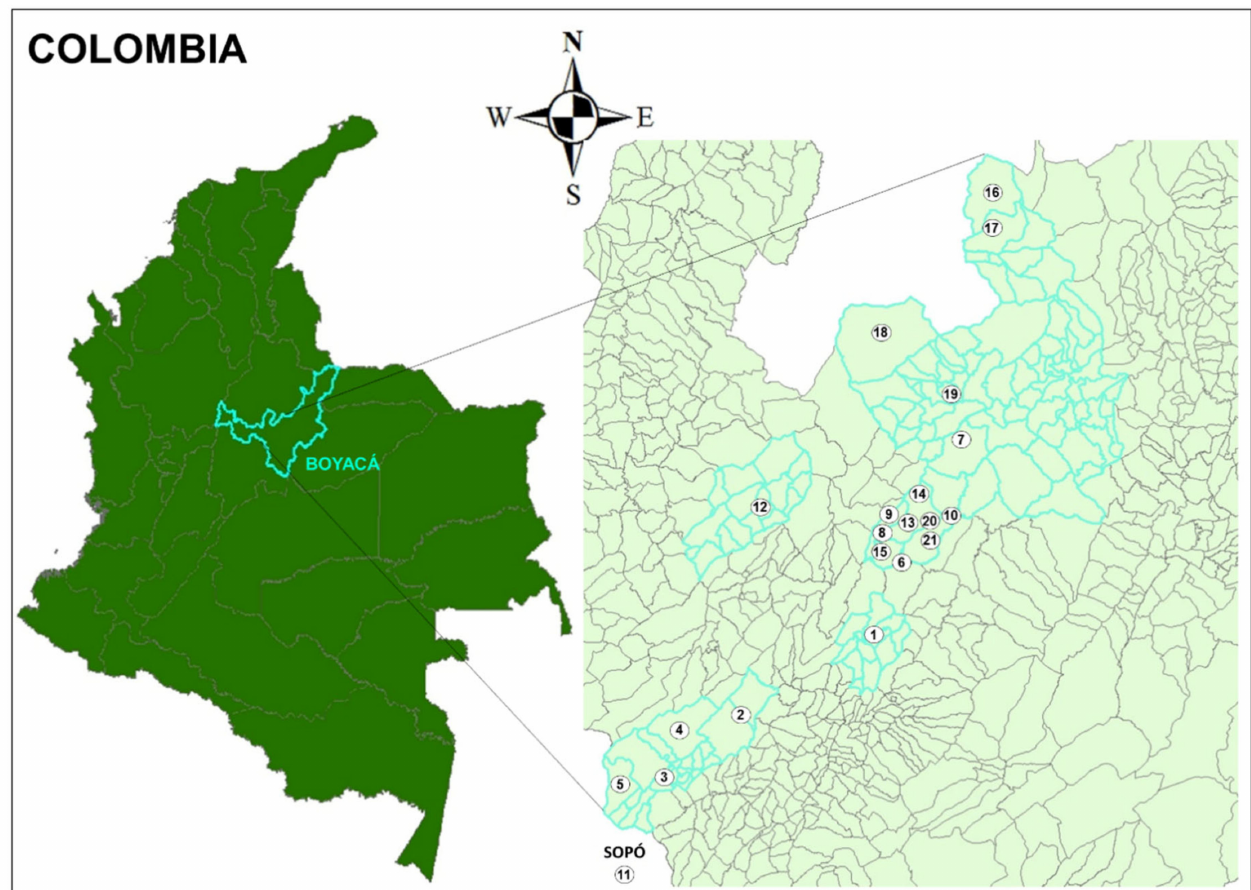
Figure 1. Map of study sites in Colombia. Farms are indicated by numbers, corresponding to those in Table 1. Table 1. Herd-level descriptive data on a convenience sample of 21 dairy herds in Boyac á department (Columbia) that were tested for antibodies to 7 Leptospira serovars using microscopic agglutination test. N. of Animals Herd Municipality